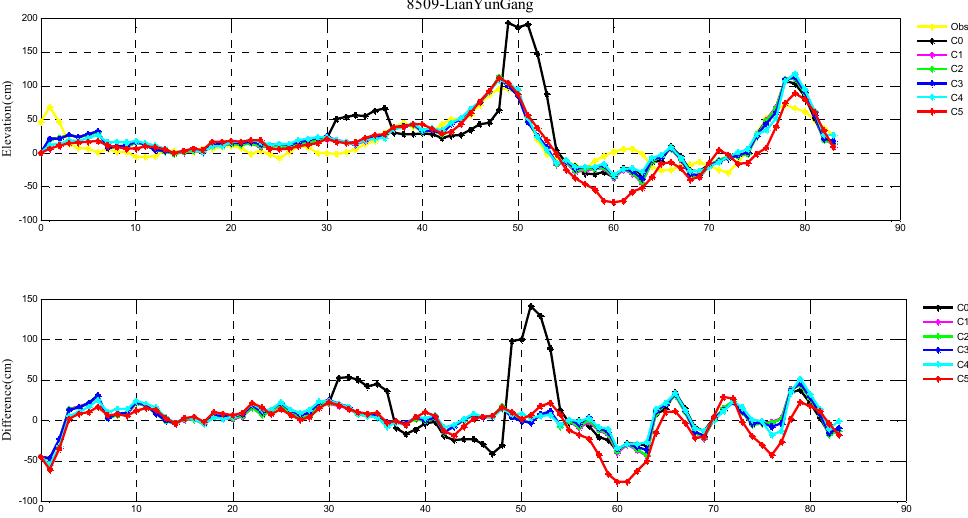
Figure 8. The storm surge elevations (cm) in six cases (C0, C1, C2, C3, C4, C5) and observations (yellow line) (top) and the differences between them (bottom) during Typhoon 8509 at LianYunGang tide station.